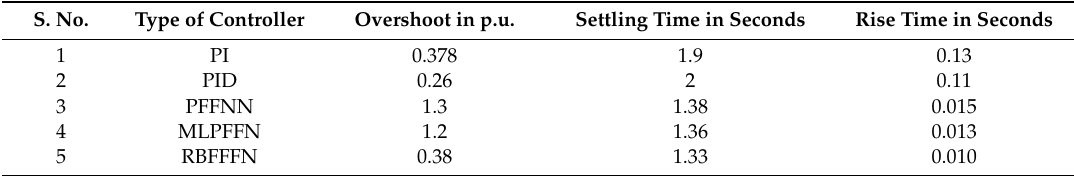
Table 2. Active power at stator side.